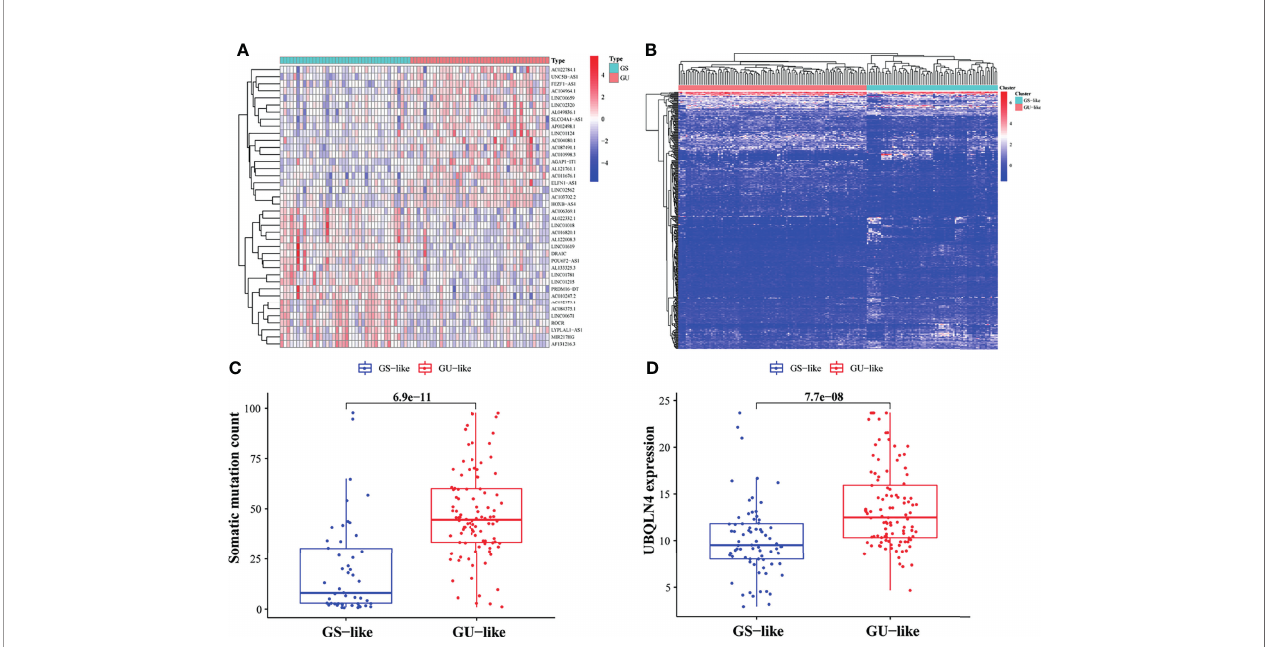
FIGURE 2 | Screening and validation of lncRNAs associated with genomic instability (GILncRNAs). (A) GILncRNAs were selected by comparing gene expression levels of the gene stable and gene unstable (GU) groups. Twenty GILncRNAs with the most obvious upregulation and downregulation were separately shown in the heat map. (B) 409 GILncRNAs were classi fi ed using the clustering algorithm. The genomic stable-like (GS-like) group is depicted in the left red cluster, whereas, the genomic unstable-like (GU-like) group is described in the right blue cluster. (C) Comparison of somatic accumulative mutation count between the GS-like and GU- like groups. (D) Comparison of UBQLN4 expression level between the GS-like and GU-like